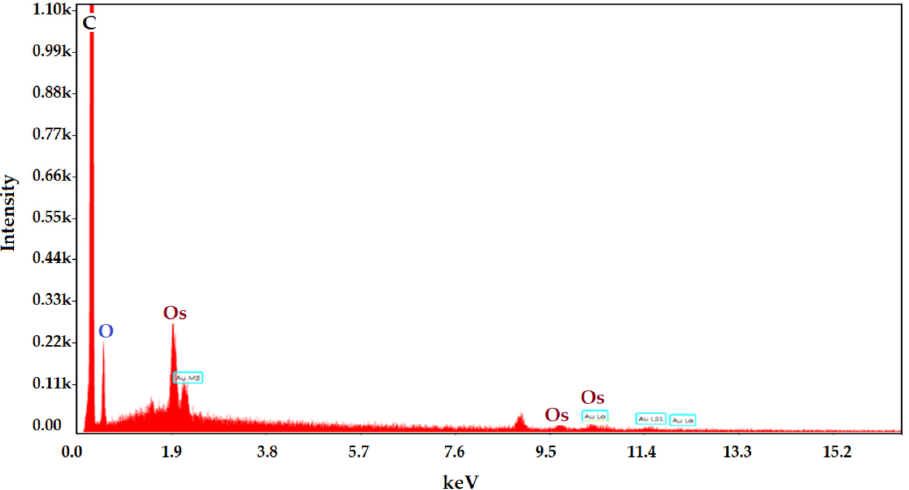
Figure 7. The surface spectrum of the membrane nanodispersion sample obtained by energy ‐ dispersive spectroscopy analysis (EDAX).